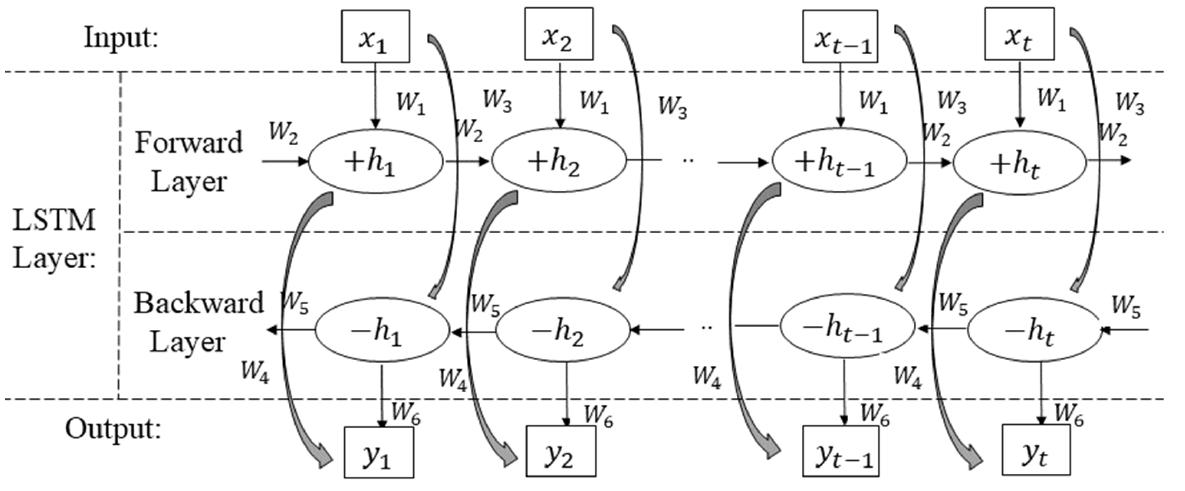
Figure 1. BiLSTM unit structure.